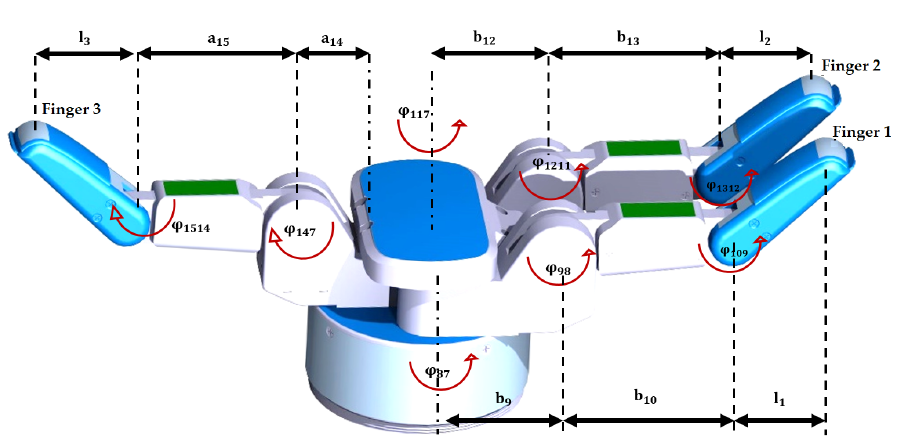
Figure 4. Barrett hand: dimensions, frames, and